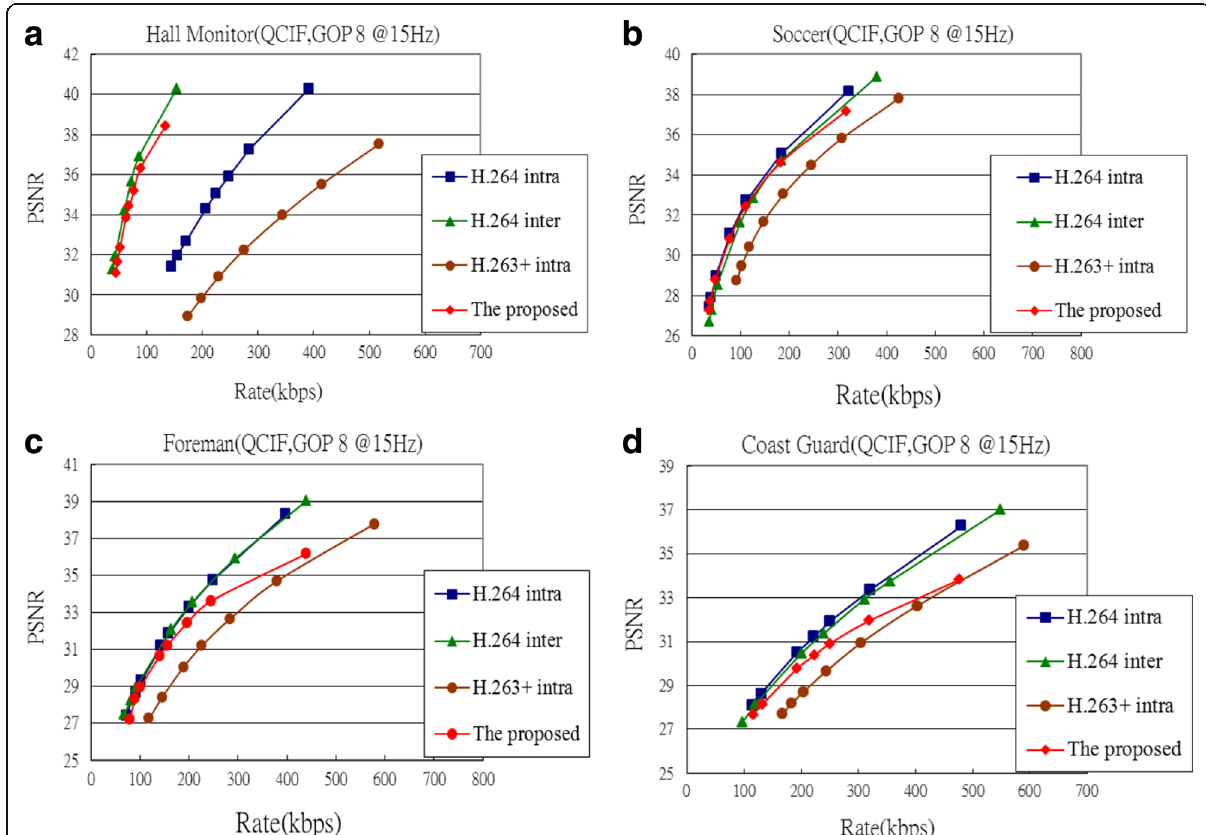
Fig. 11 The RD performance of the proposed scheme compared to that of H.264/AVC and H.263+ in GOP